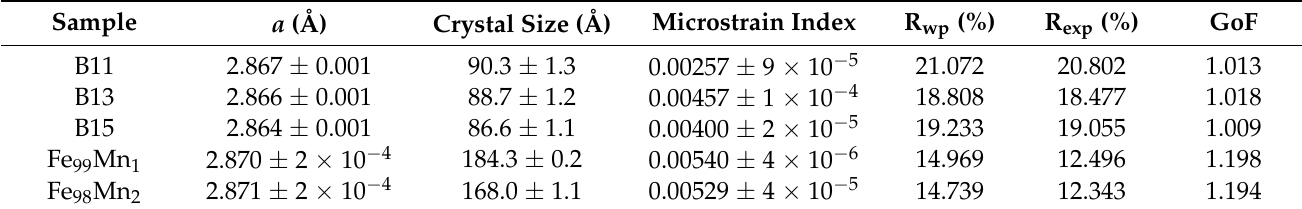
Figure 5. XRD diffractograms for samples B11, B13, B15, Fe 99 Mn 1 , and Fe 98 Mn 2 . Other results obtained include the cell parameter, crystal size, and microstrain index. The specific results for each sample are presented in Table 2. Also, relevant refinement parameters are included. These parameters are the weighted residual (R wp ), expected residual (R exp ), and the goodness of fit (GoF). Table 2. Crystallographic parameters and Rietveld refinement results obtained by MAUD.